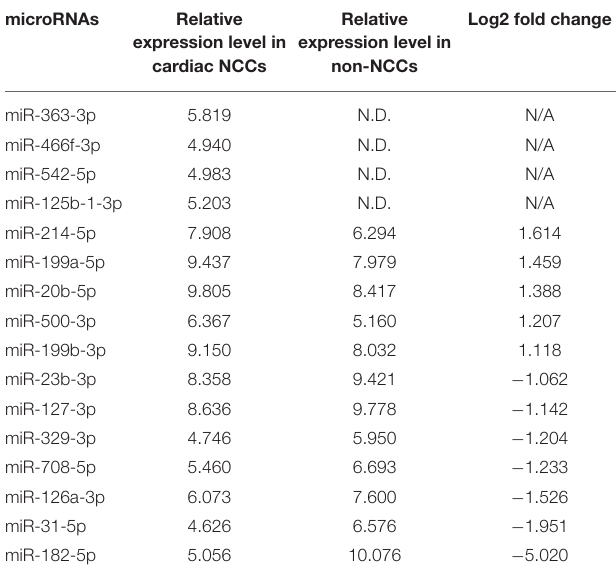
Number in control group case group